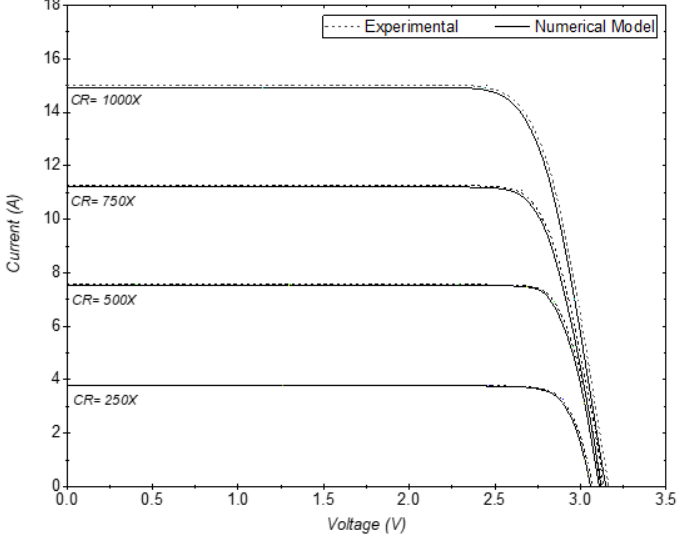
Figure 9. Verification of the mathematical model results with the datasheet of I-V characteristics in different concentration ratios for FULLSUNS Triple-Junction Photovoltaic solar cell.